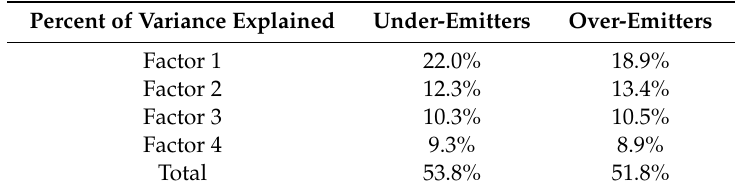
Table A1. Rotated factor analysis: percent of variation explained in the whole